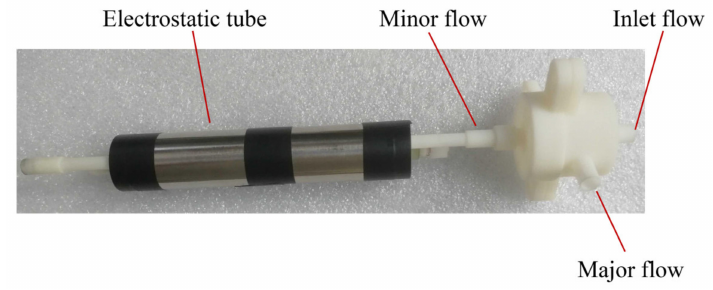
Figure 9. Photograph of the sampler.